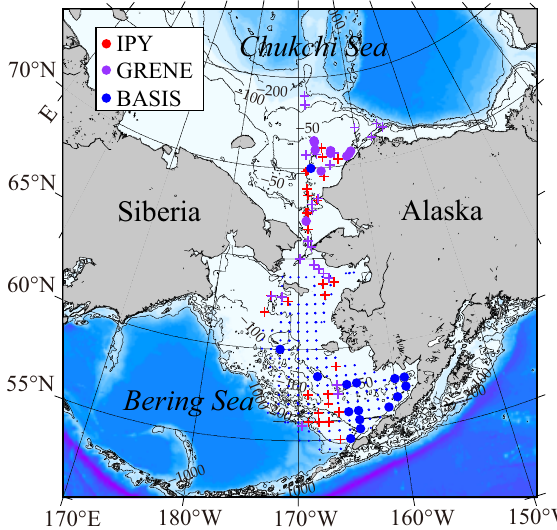
Figure 1. Location of in situ sampling stations for the IPY cruises (red), GRENE cruises (violet), and BASIS cruises (blue). Note that the stations of the daily matches between the in situ F L measure- ments and MODIS level-2-derived F L values are shown in large circles, and crosses represent the sites where primary productivity measurements were conducted. Contours indicate the 100m, 200m, and 1000m bathymetry lines, based on ETOPO-2.